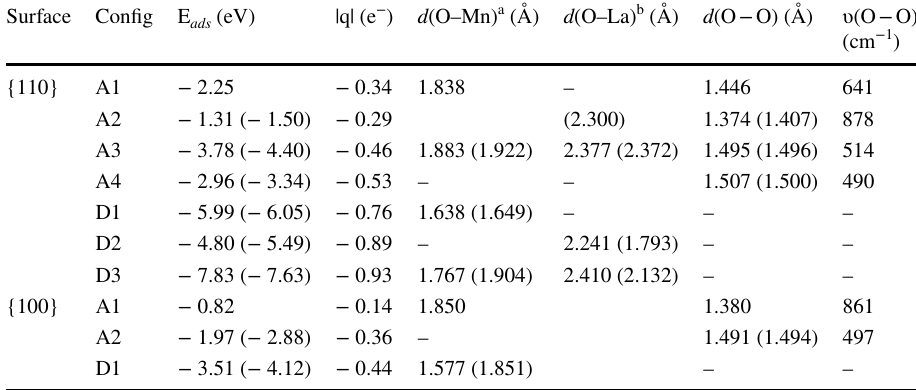
The (2 × 1) values are given in parenthesis a,b The shortest distance between an adsorbed oxygen species and an Mn or La ion